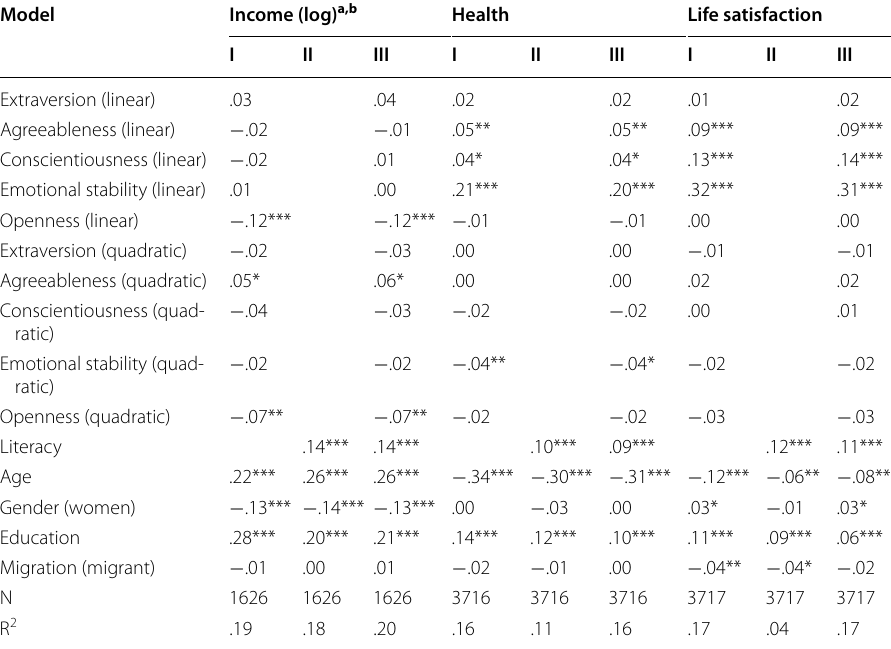
Table 7 Relationships between personality, literacy, and important life outcomes Model